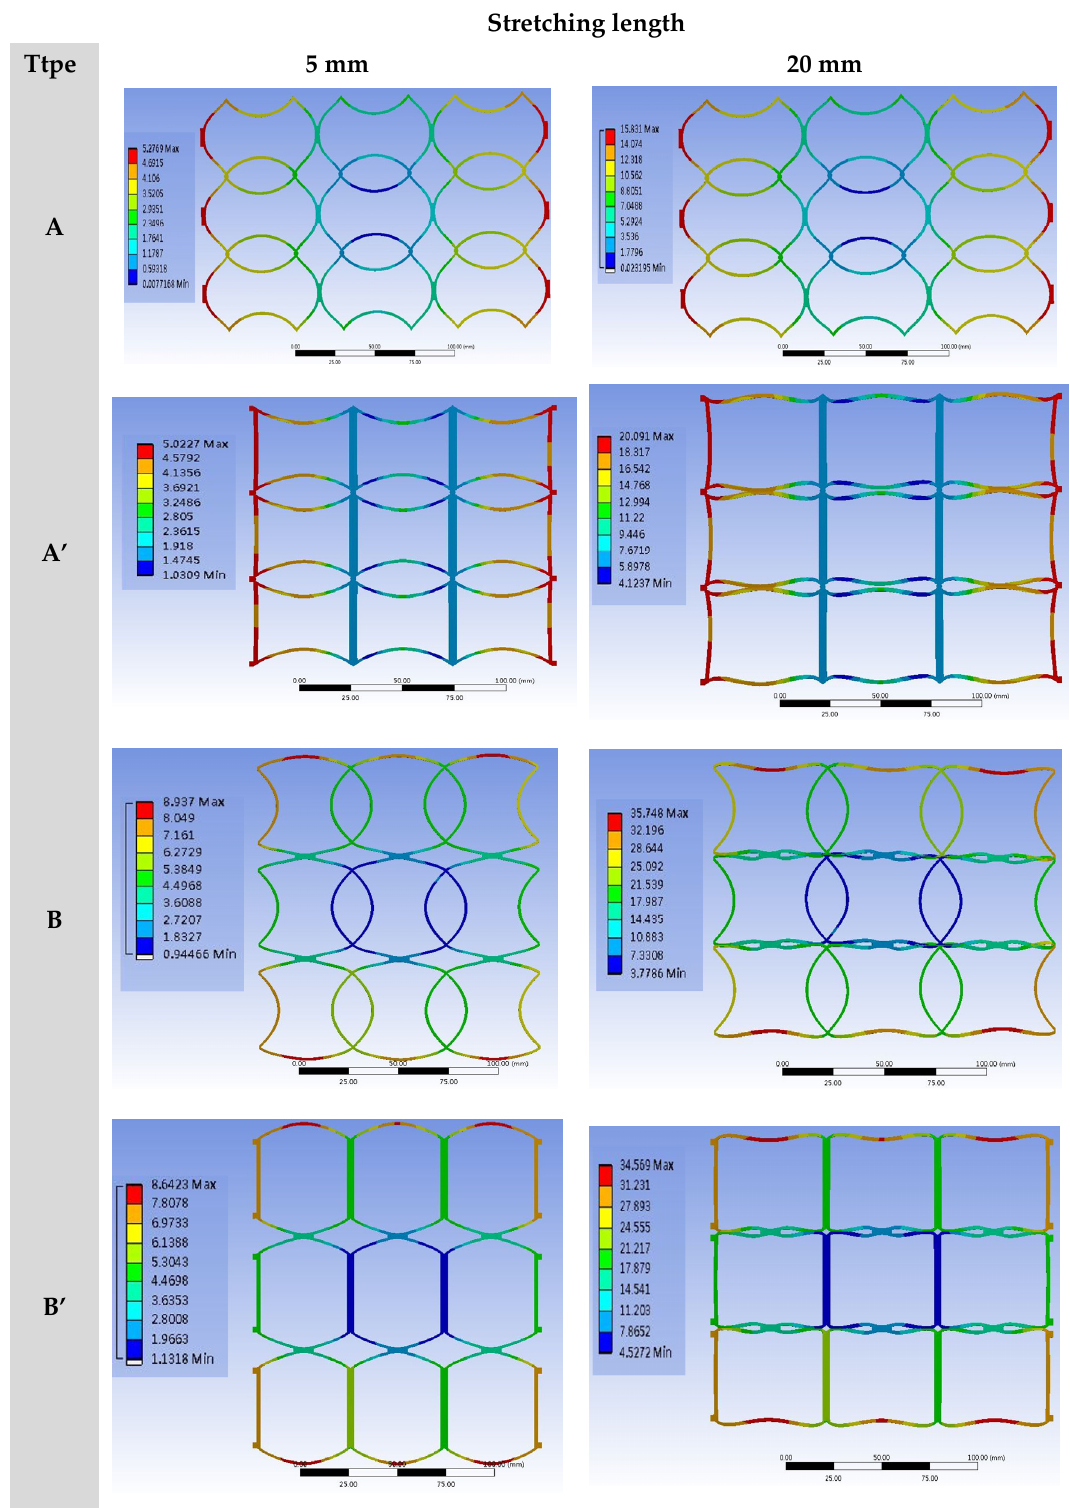
Figure 12. The basic SIN waveforms into four types for preliminary simula-tion analysis, and designed based on the results of software simulation, namely A-type, A’-type, B-type, and B’-type, and deformation simulation of 3 × 3 NPR arrays at different stretching lengths.